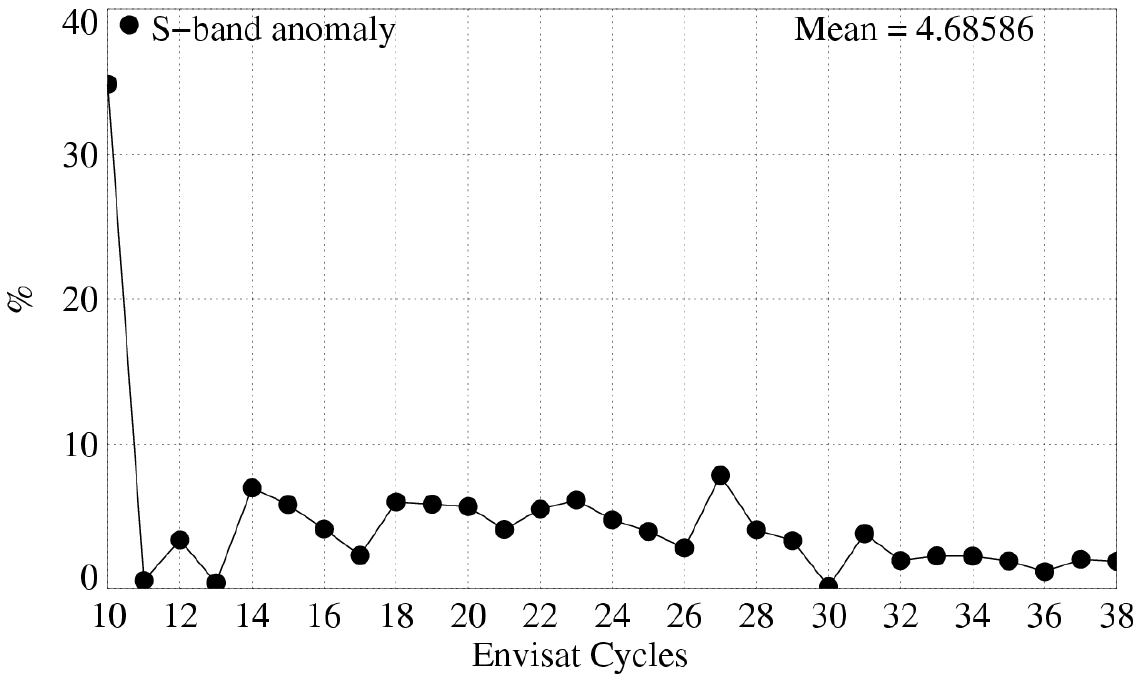
Figure 3. Cycle by cycle percentages of data impacted by the S-Band